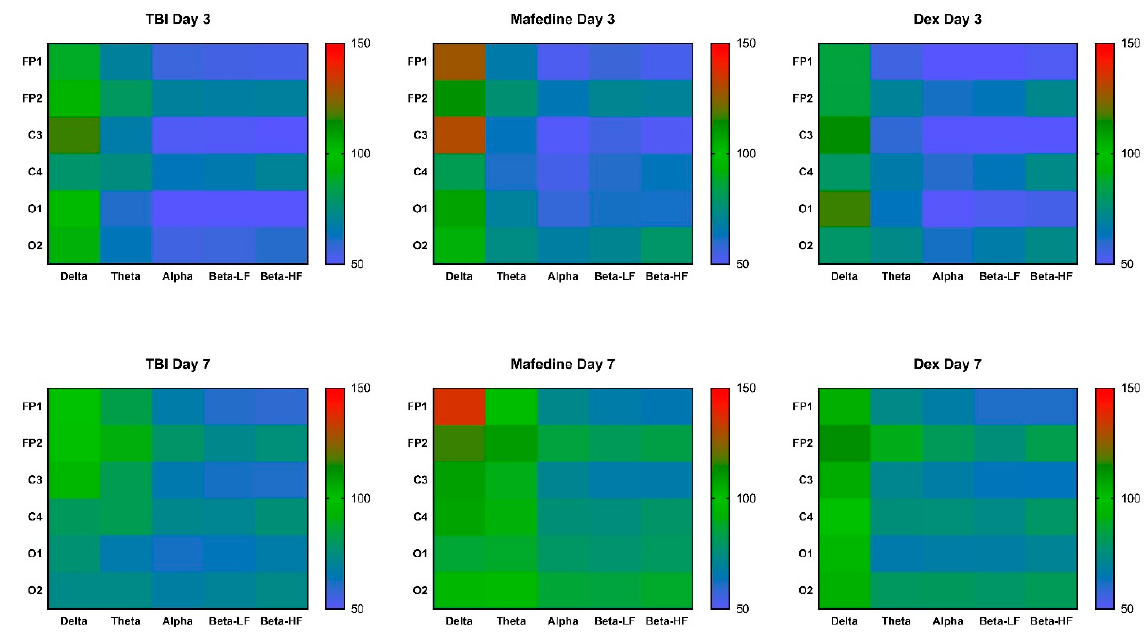
Figure 2. A heatmap of mean δ -, θ -, α -, LF and HF β -wave amplitudes in channels FP1, FP2, C3, C4, O1, and O2 at post-TBI days 3 and 7. Data were normalized to the respective healthy control values.